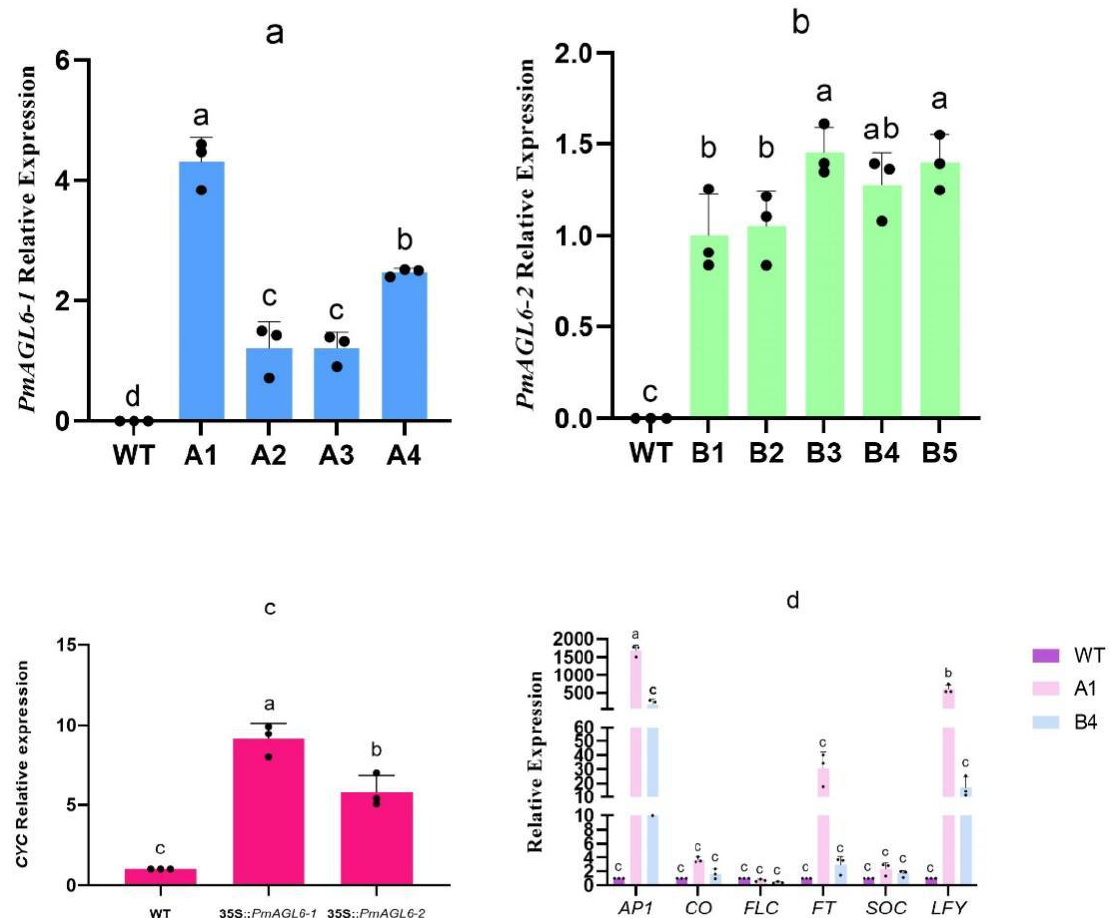
Figure 5. Analysis of related gene expression in transformants. ( a ) Expression of PmAGL6-1 in five transgenic Arabidopsis plants. ( b ) Expression of PmAGL6-2 in five transgenic Arabidopsis plants. ( c ) Expression of CYC in transgenic plants. ( d ) Expression of flowering regulators in the 35S:: PmAGL6-1 transformant A1 line and the 35S:: PmAGL6-2 transformant B4 line. Significant differences are identified by SPSS with Duncan’s test ( p < 0.05) and are represented by different letters above the error bars.